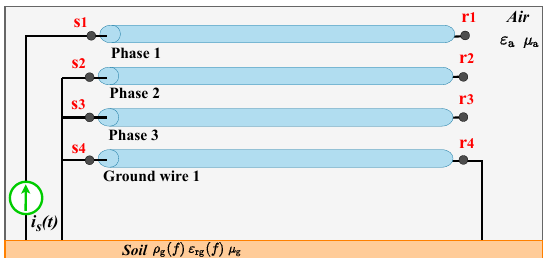
Figure 9. Single-circuit three-phase transmission line: Simulation layout. Table 3. Simulation results for the single-circuit three-phase TL of Figure 9. Lightning